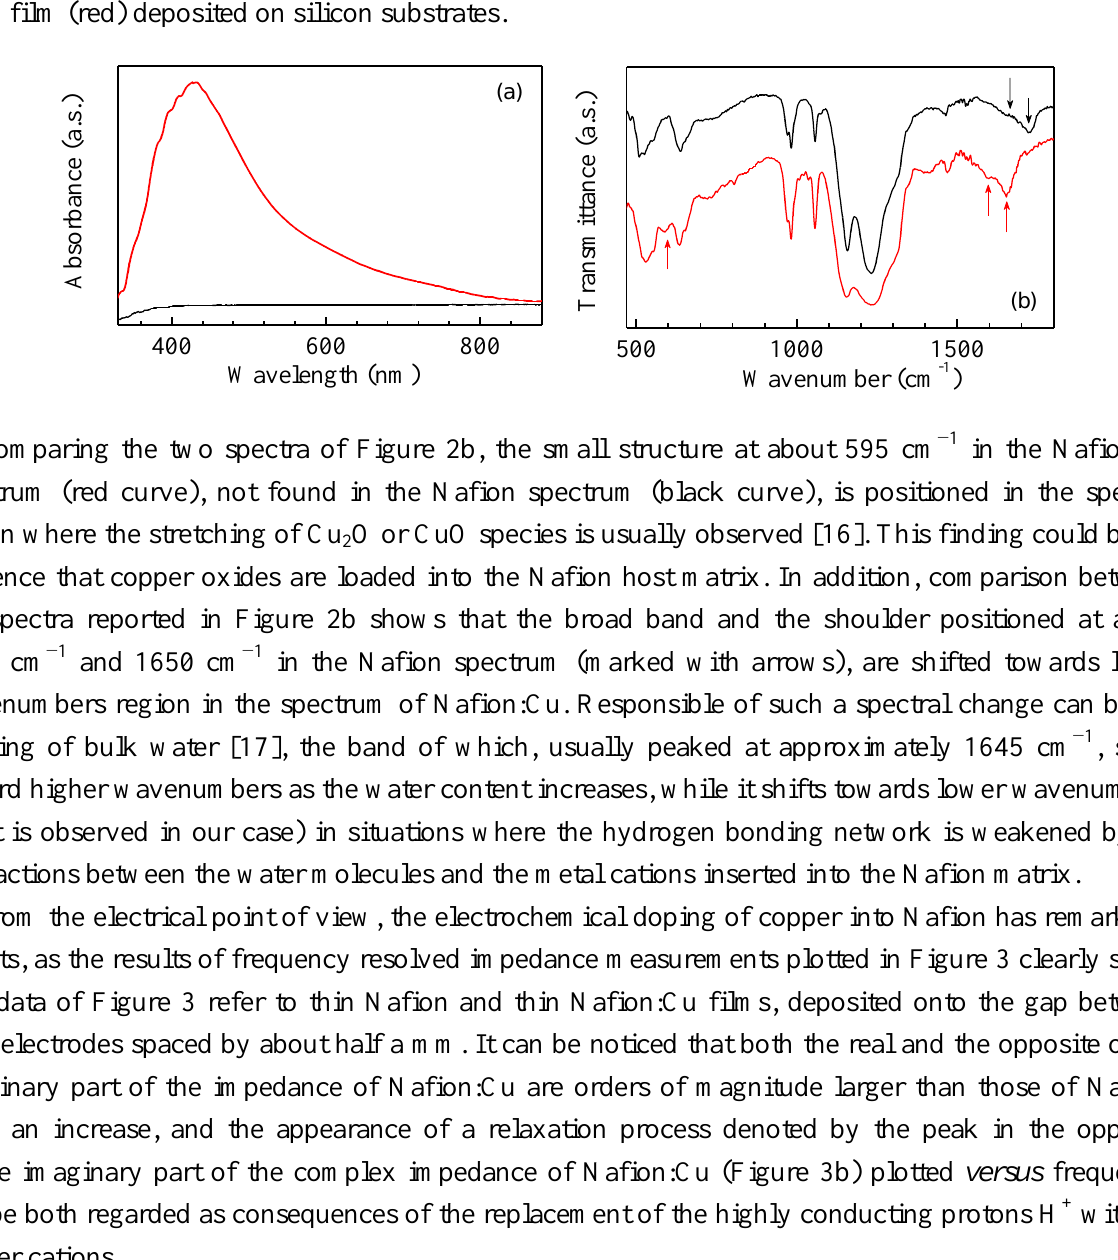
Figure 2. ( a ) Optical absorbance spectrum of a Nafion film (black) and of a Nafion:Cu film (red). ( b ) Infrared transmittance spectrum of a Nafion film (black), and of a Nafion:Cu film (red) deposited on silicon